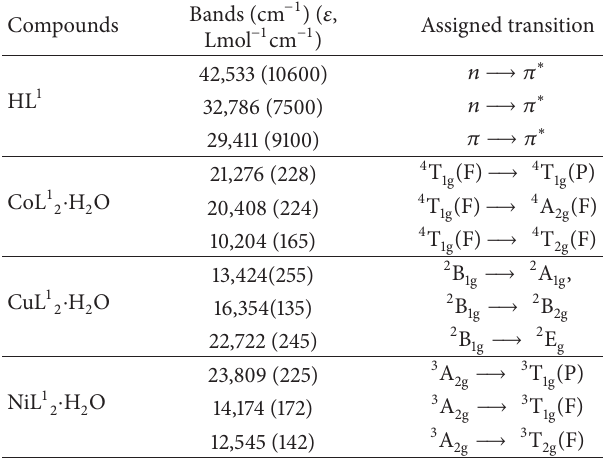
Table 5: Electronic spectra data of ligand and metal complexes.